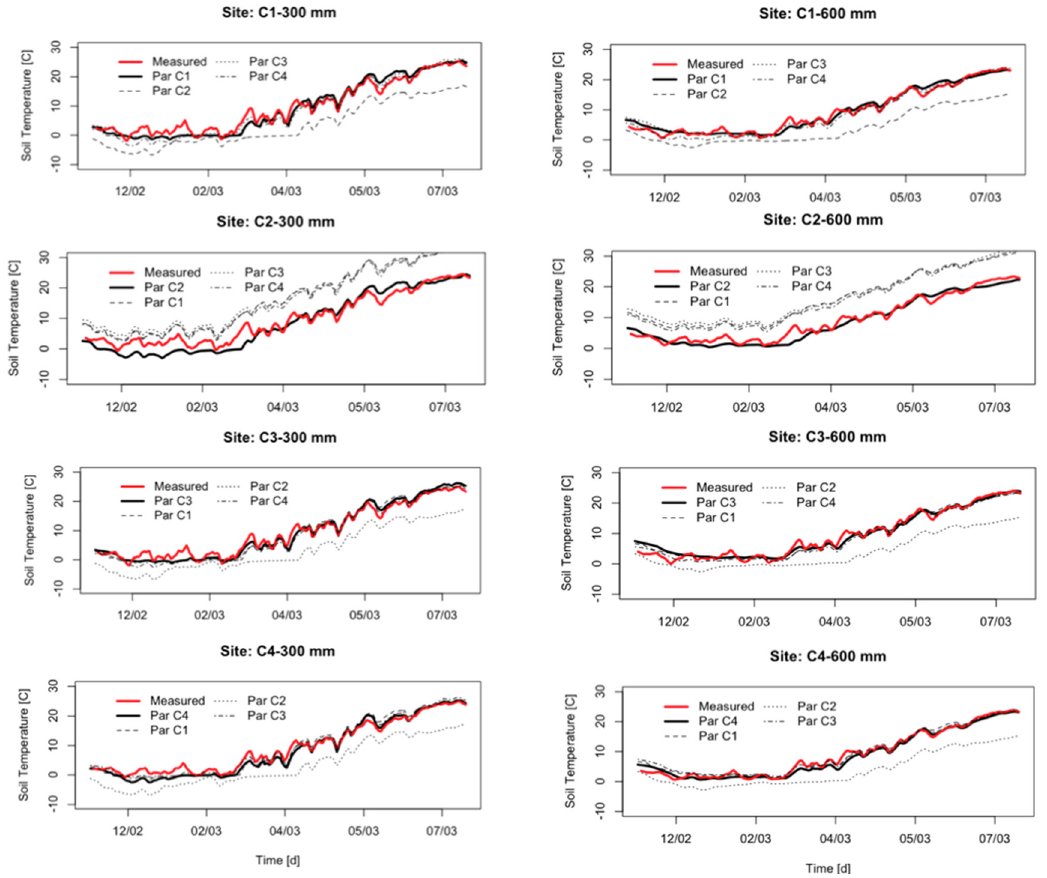
Figure 7. Soil temperature dynamics at different depths (300 and 600 mm) in locations C1, C2, C3, and C4. The red bold lines are the measured data. The black lines are simulated ST values computed by using a different parameters set (Par_C1, Par_C2, Par_C3, and Par_C4), as specified in the legend.